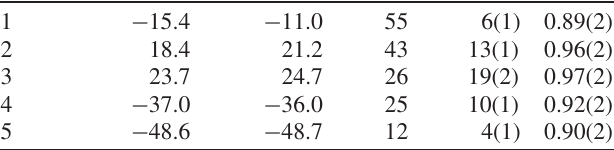
TABLE I. Experimentally determined parameters of the five 13 C nuclear spin qubits used in this work: hyperfine couplings A and A ⊥ , precession frequency difference Δ ω , and combined initialization and readout fidelity F i;r . The hyperfine parameters are measured via dynamical decoupling spectroscopy [31] and have an uncertainty in the last digit. 13